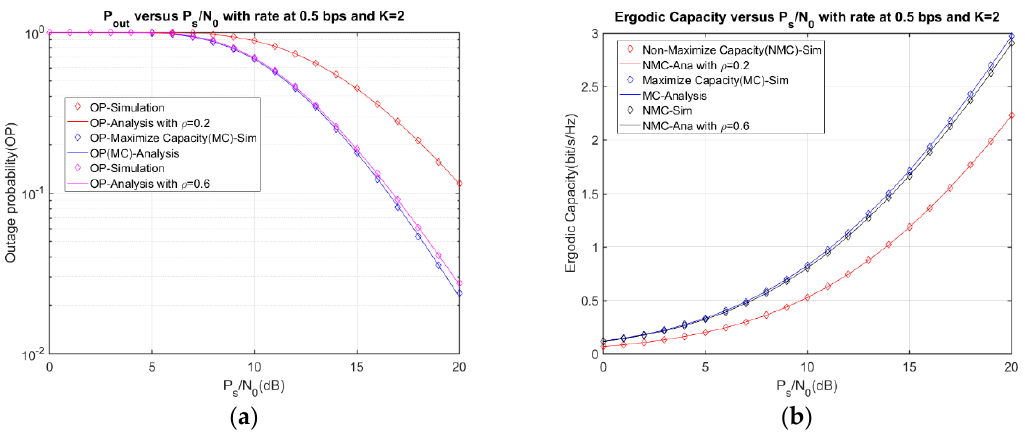
Figure 3. The outage probability ( a ) and ergodic capacity ( b ) versus P s /N 0 while K = 2.